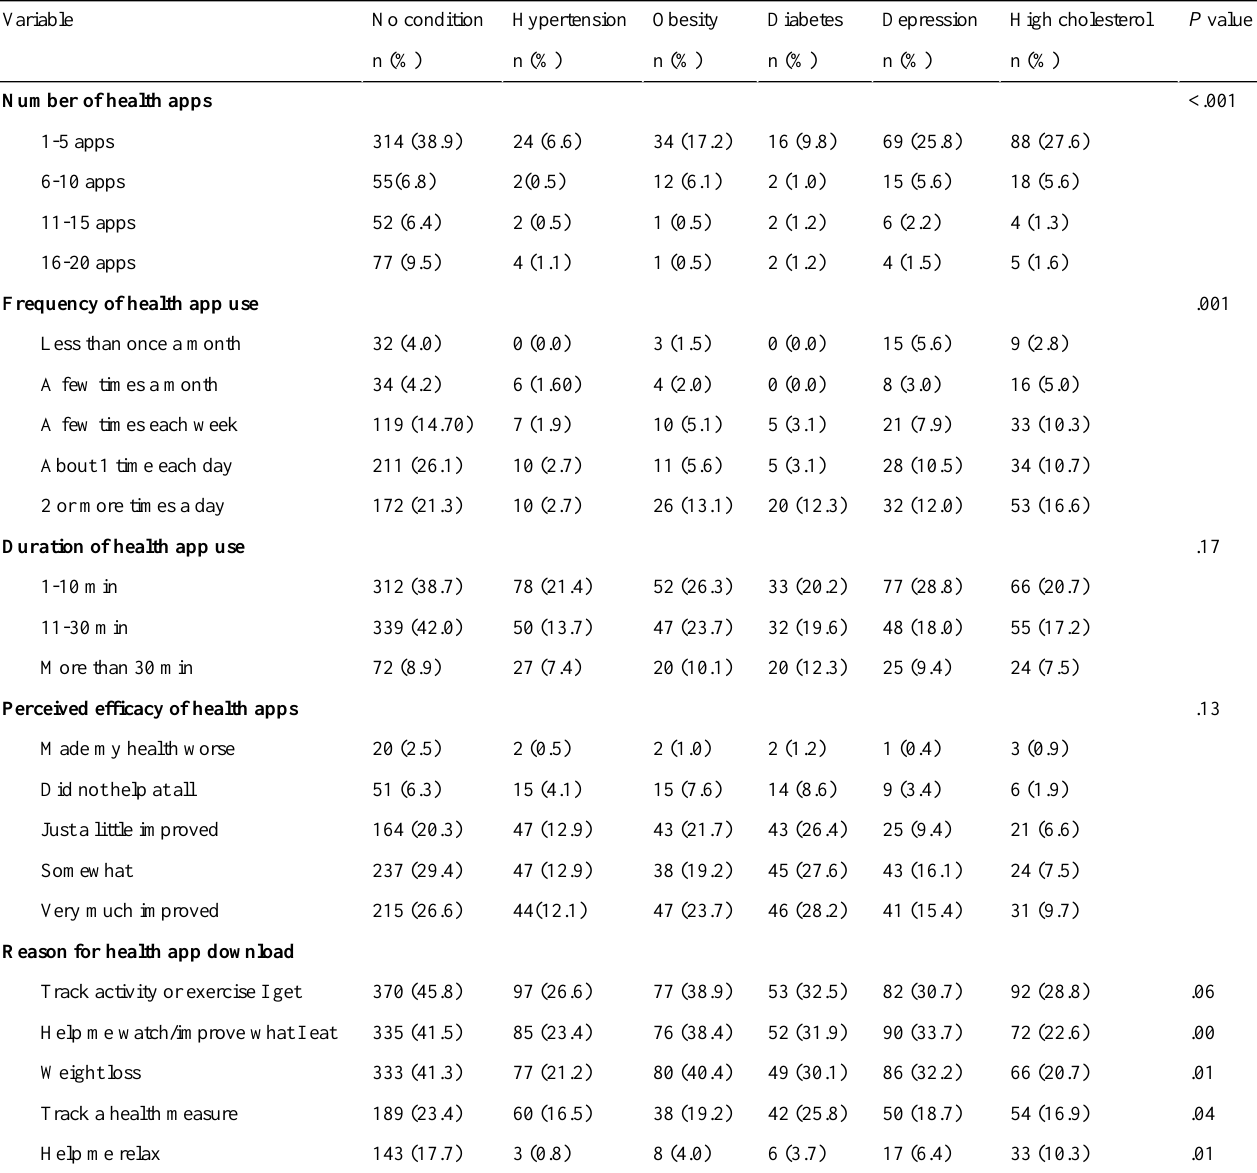
Table 2. Responses to health app use, frequency, and perceived efficacy by chronic condition (N=1604).